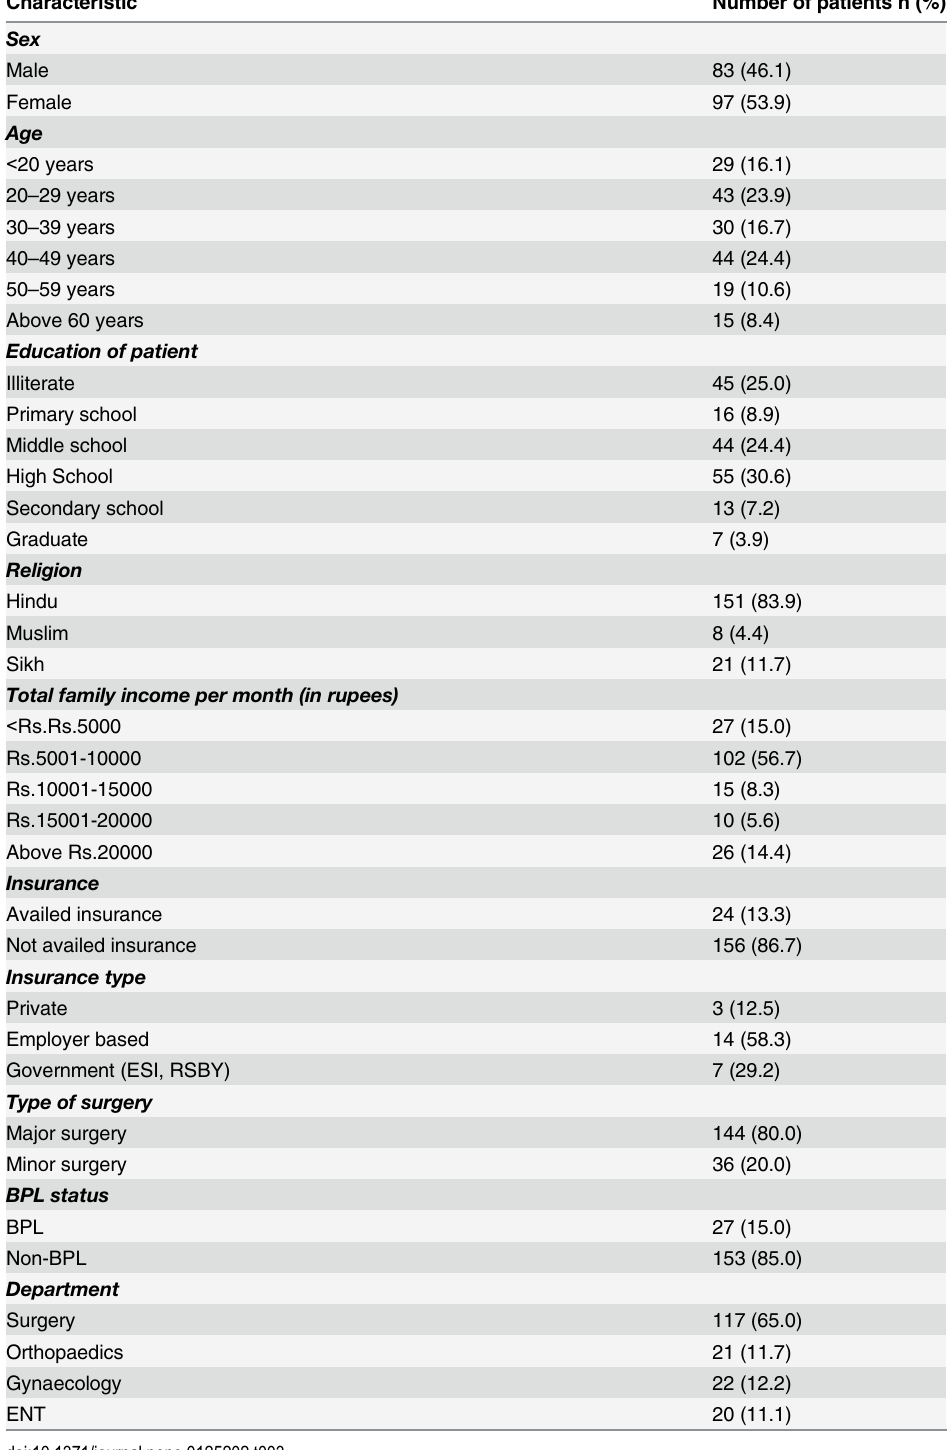
Table 3. Background characteristics of the patients for assessment of out-of-pocket